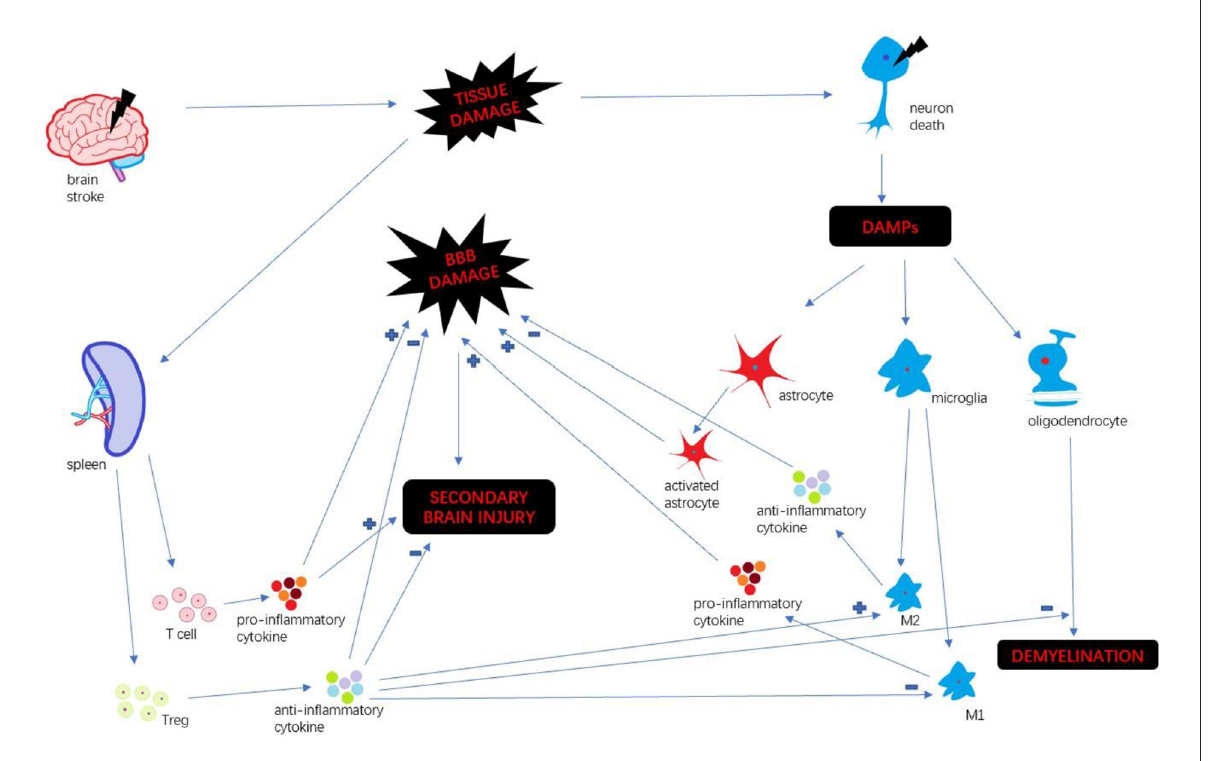
FIGURE1 Inflammatory mechanism after stroke.